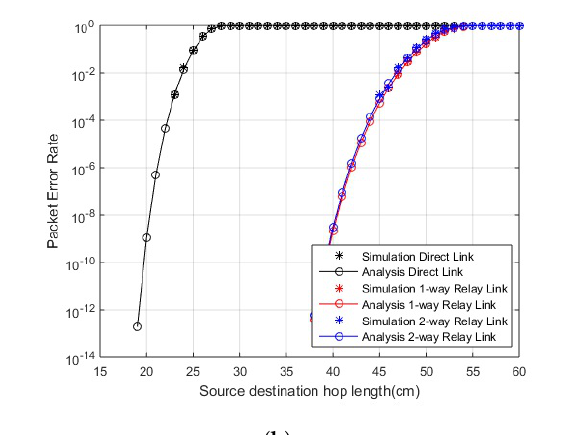
Figure 2. Packet error rate (PER) for in-body communication.